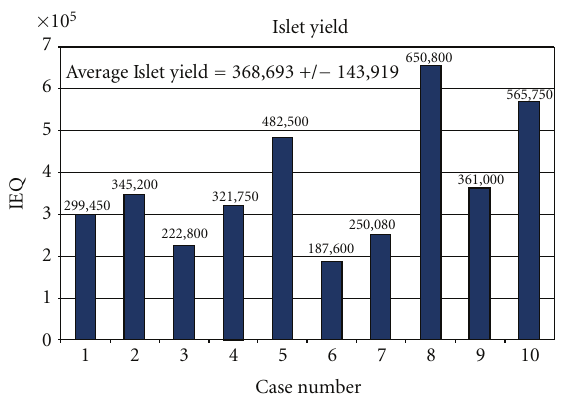
Figure 1: Islet yield expressed as islet equivalent numbers.